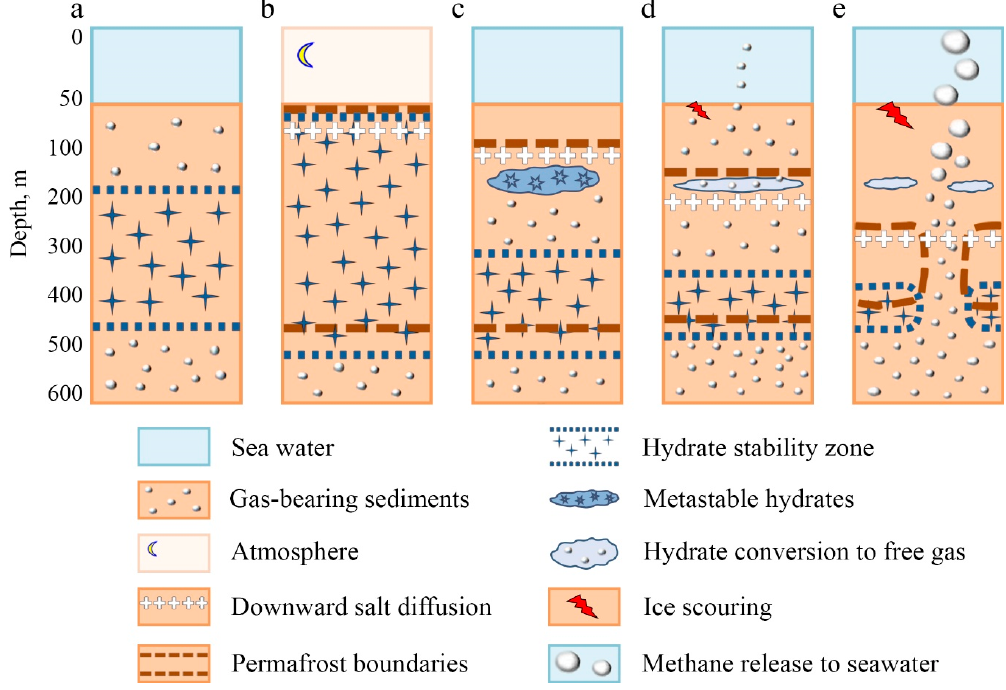
Figure 4. Schematic diagram presenting current understanding of the subsea permafrost–hydrate system existing in the ESAS. ( a ) Prior to exposure to atmosphere; ( b ) permafrost formation; ( c ) the ESAS is submerged; ( d ) destabilizing hydrates allow CH 4 release; ( e ) increasing CH 4 emissions from ESAS to atmosphere. Detailed explanations are found in the text.